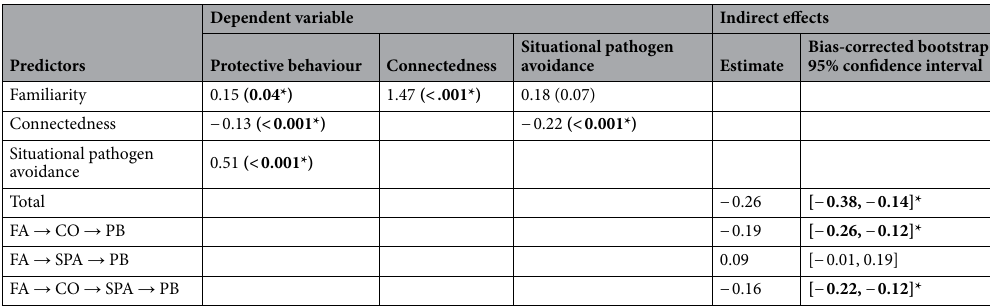
Table 2. Mediation analyses model 2. In study 1, two mediation models with two mediators (connectedness and disgust) were calculated. Mediation model 2 refers to the outcome variable own protective behaviour. Table 2 shows the direct effects (β) in the mediation models and the indirect effects in mediation model 2. p-values less than 0.05 are assumed to be significant (*). An indirect effect is assumed as significant if the 95% CI does not include 0 (*).